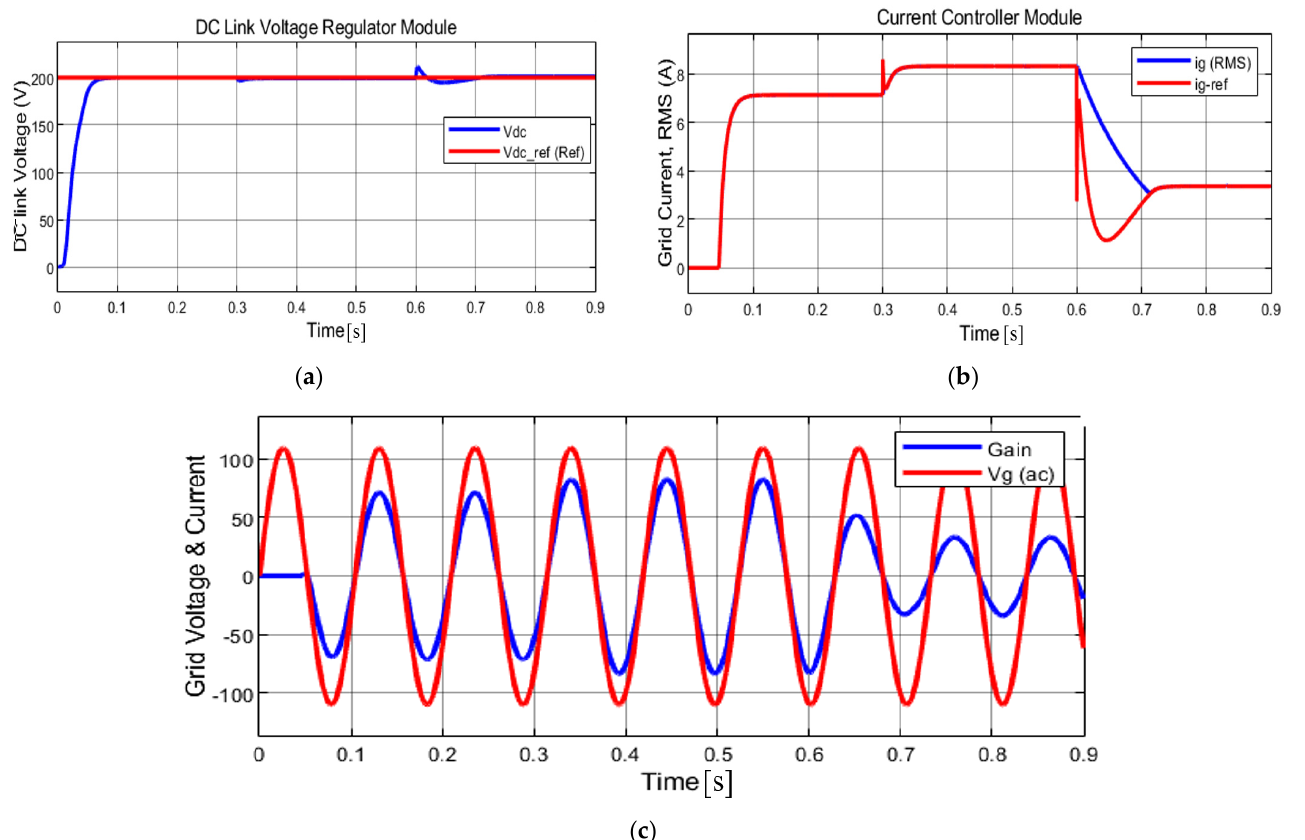
Figure 11. DC link voltage regulator module and current controller module performances with the LQR method for constant temperature case: ( a ) DC link voltage; ( b ) grid current magnitude; ( c ) grid voltage waveform V g ( V ) and current waveform where Gain is 10 × 𝐼𝑔 (𝐴)